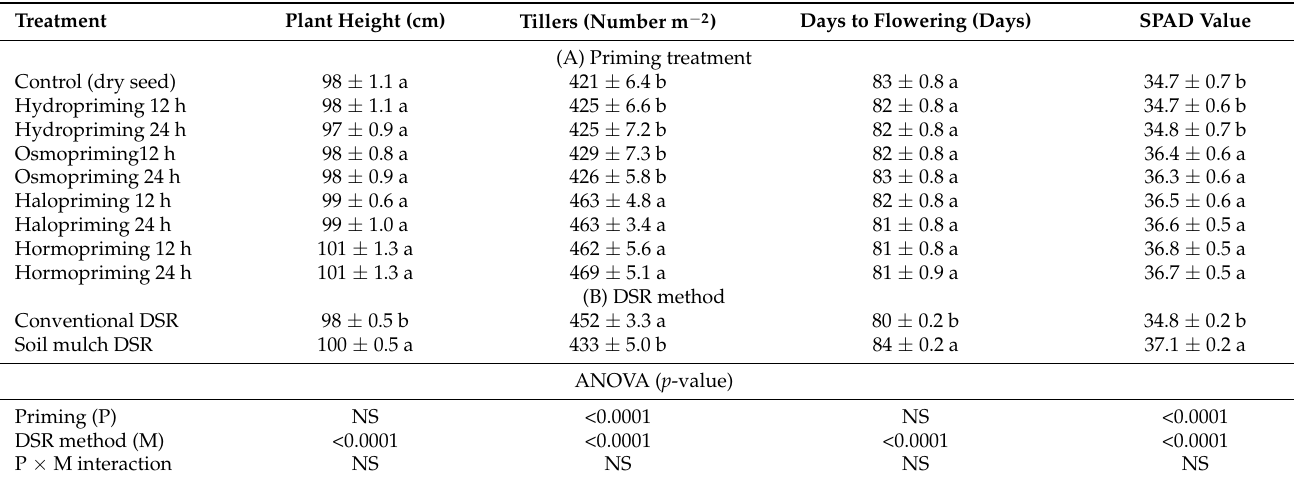
Table 5. Plant height, tiller number, days to flower and SPAD value as affected by different seed priming and DSR establishment methods during 2019 at Ludhiana, India.